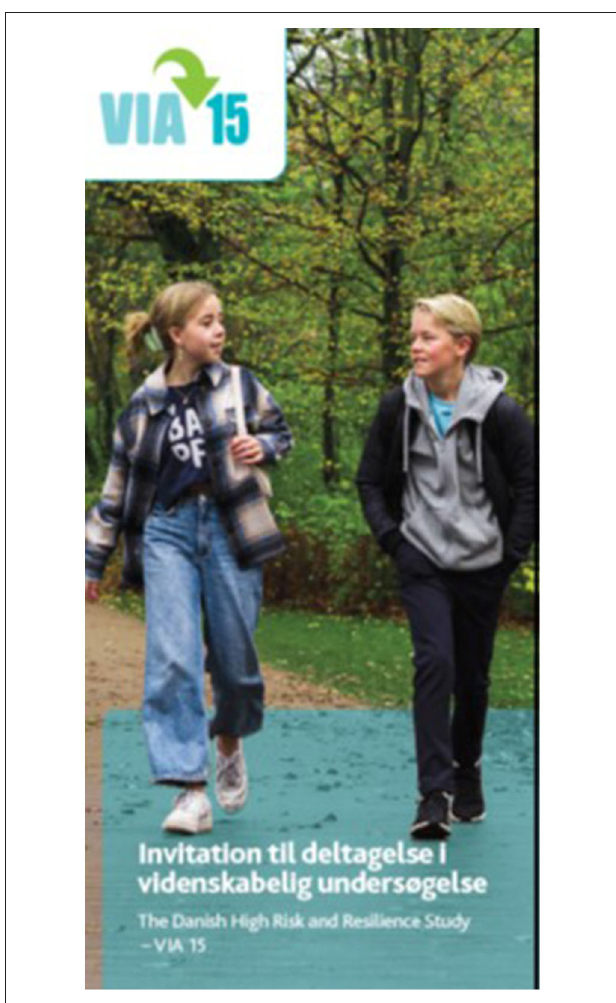
FIGURE 2 | Image of the folder sent to all participating families in the VIA 15 study by